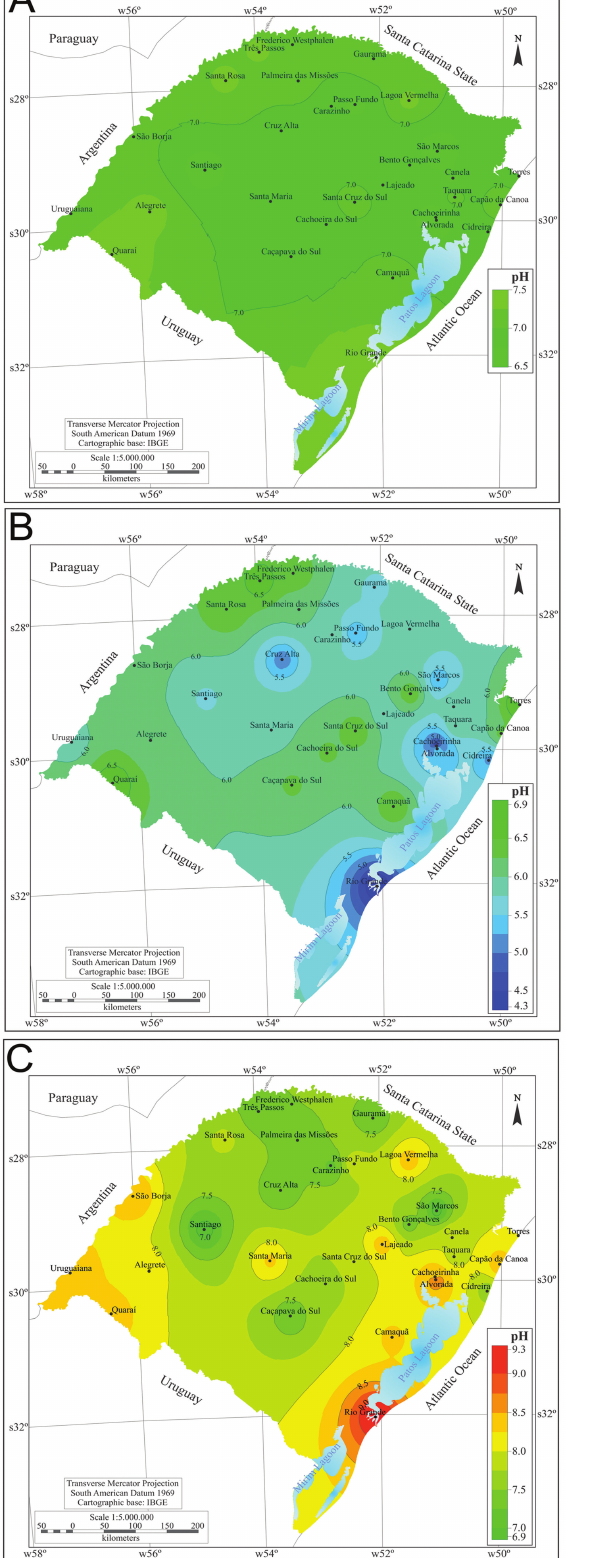
Fig. 1. Water pH in different cities of Rio Grande do Sul in the period of 1996 to 2011 (A) mean, (B) minimum and (C) maximum values (Source CORSAN/RS).